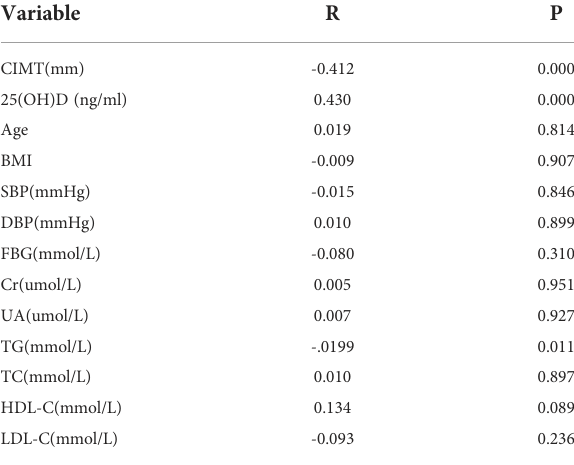
TABLE 2 Correlation analysis between IIEF-5 score and different indicators.